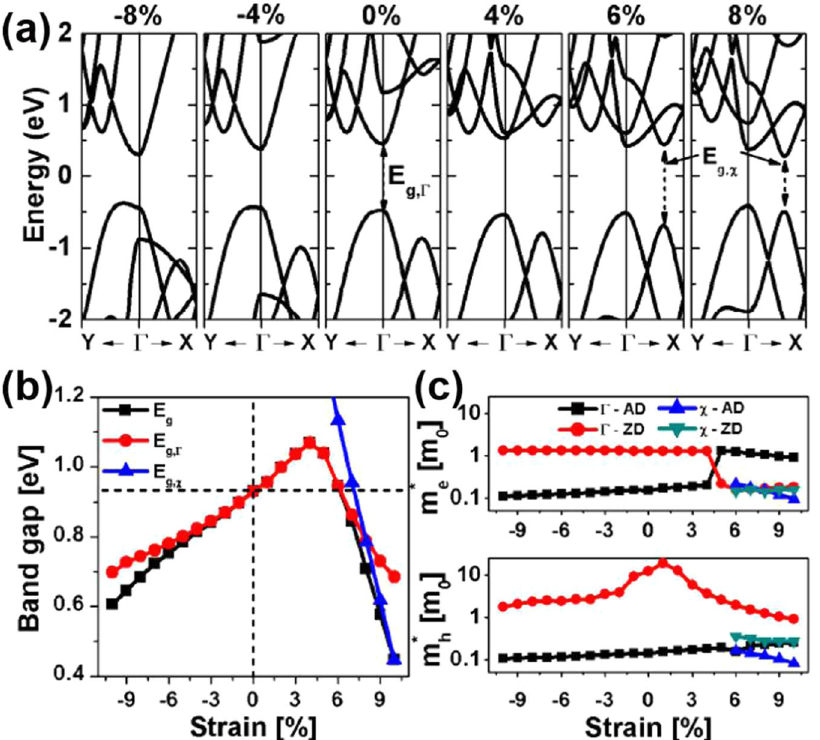
Fig. 16 Simulation Report of Nanoscale 2D Ph-TFET. Plots of a E-k dispersion relation and b Energy band-gap and c effective mass of Phosphorene under applied uniaxial strain, adapted with permission from 103 . Copyright (2017) IEEE. npj 2D Materials and Applications (2022)